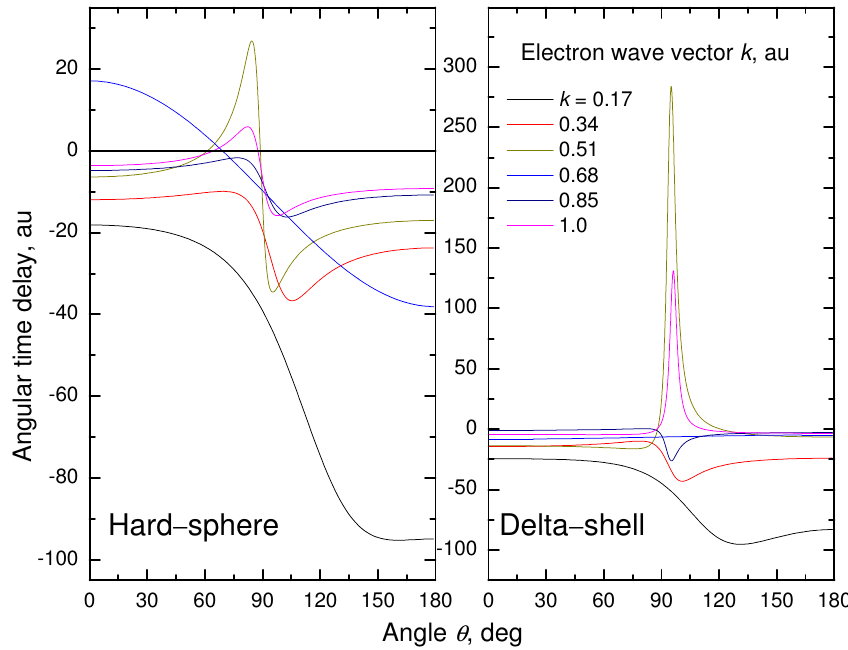
Figure 1. Angular time delay ∆ t ( k , θ ) 01 (9) as a function of the polar angle θ for fixed electron wave vectors k . The functions P 0 ( cos θ ) and P 1 ( cos θ ) used in (9) is the pair of Legendre polynomials in the amplitude of electron elastic scattering f ( k , θ )